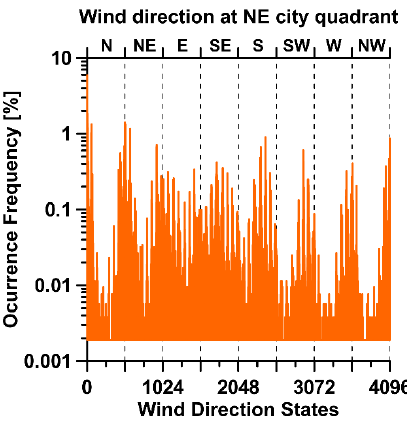
Figure 9. Occurrence frequencies of Mexico City wind direction states for the period of